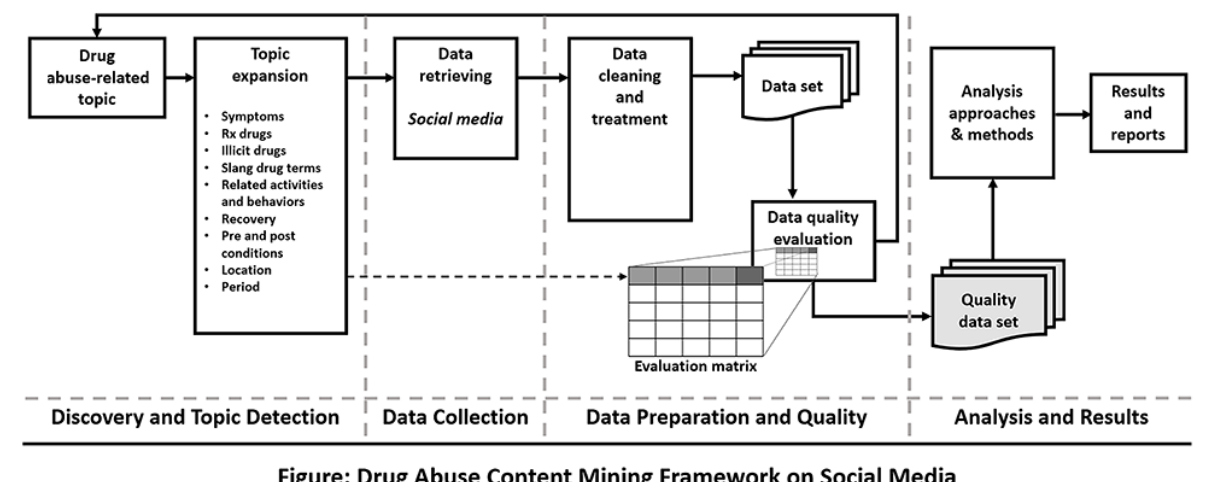
Figure 1. Social media text mining framework for drug abuse. Rx: prescription.